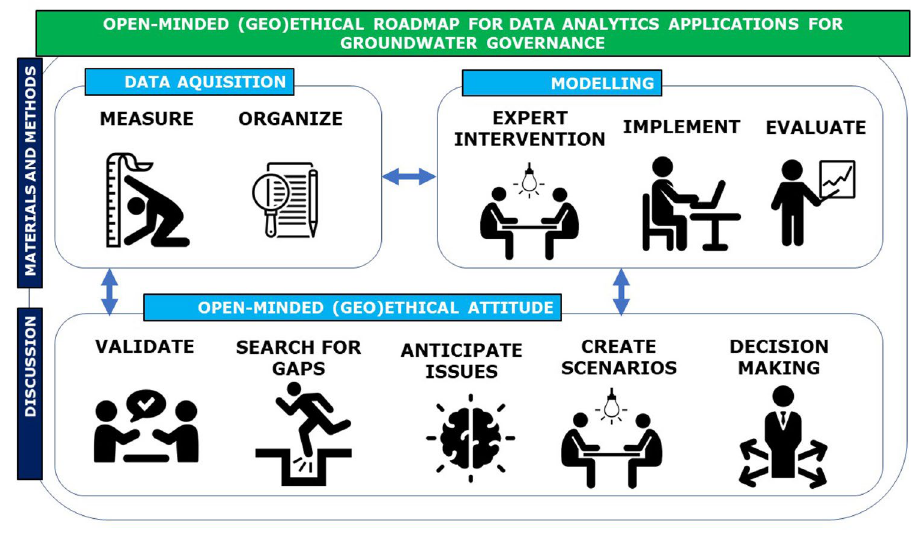
Fig. 2 Open-minded (geo)ethi- cal roadmap for data analytics applications for groundwater